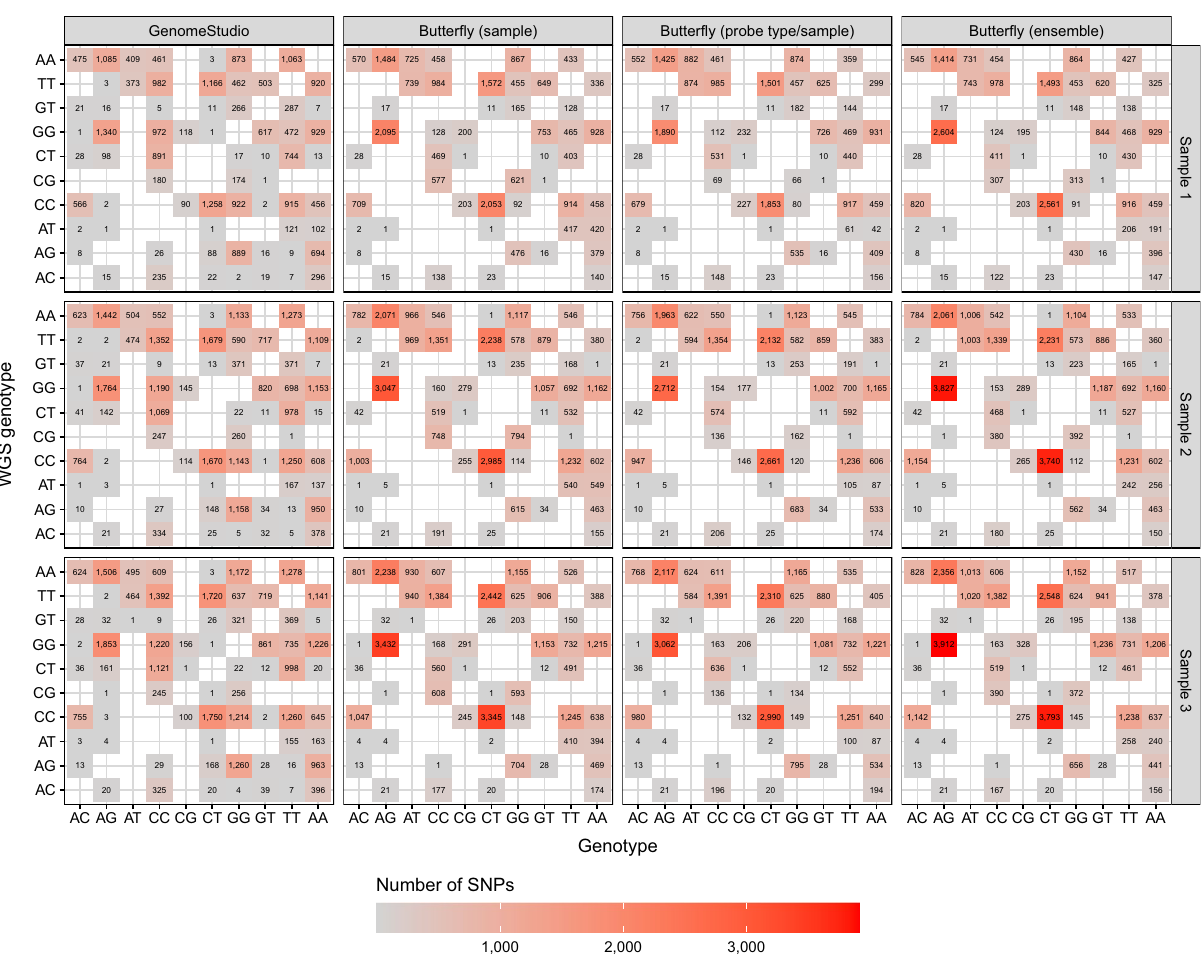
Figure 7. Discordant calls (excluding no-calls) for the samples with 400 ng DNA. The butterfly methods had an a posteriori probability threshold of 0.8 and a number of beads threshold of 0. See Fig. 8 for results for all genotypes. There is no obvious structure in these discordant calls, except possibly a small indications that all methods seem to call too few homozygous genotypes (Fig.